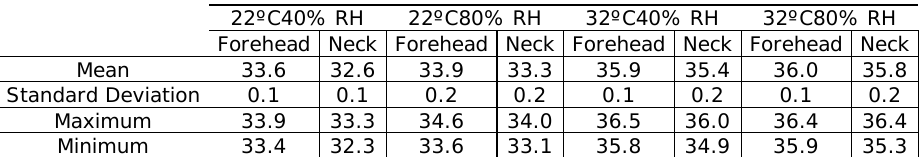
Table 1. Statistical parameters for forehead and neck temperature (ºC) between minute 30th and minute 90th.